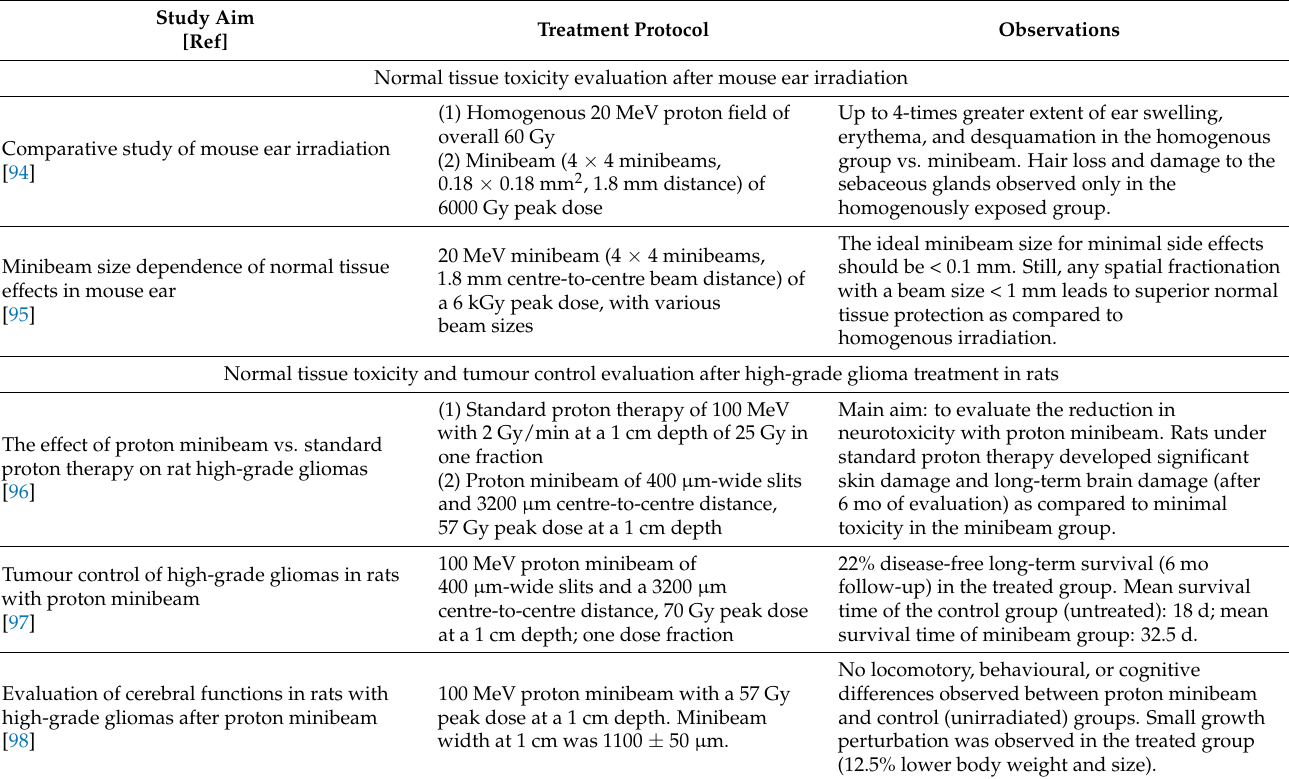
Table 2. Compilation of animal studies investigating normal tissue effects and/or tumour control after proton minibeam